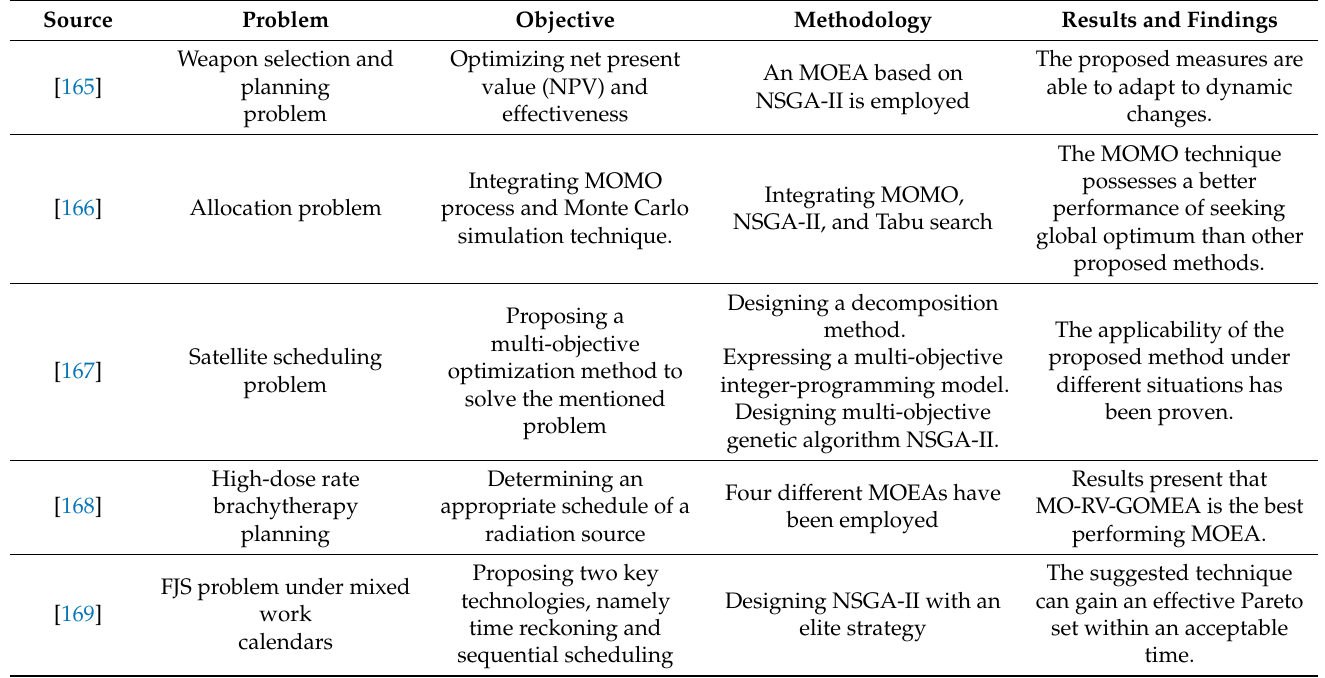
Table 3. Summary of the literature review on NSGA-II applications in different fields, along with methodology and results.